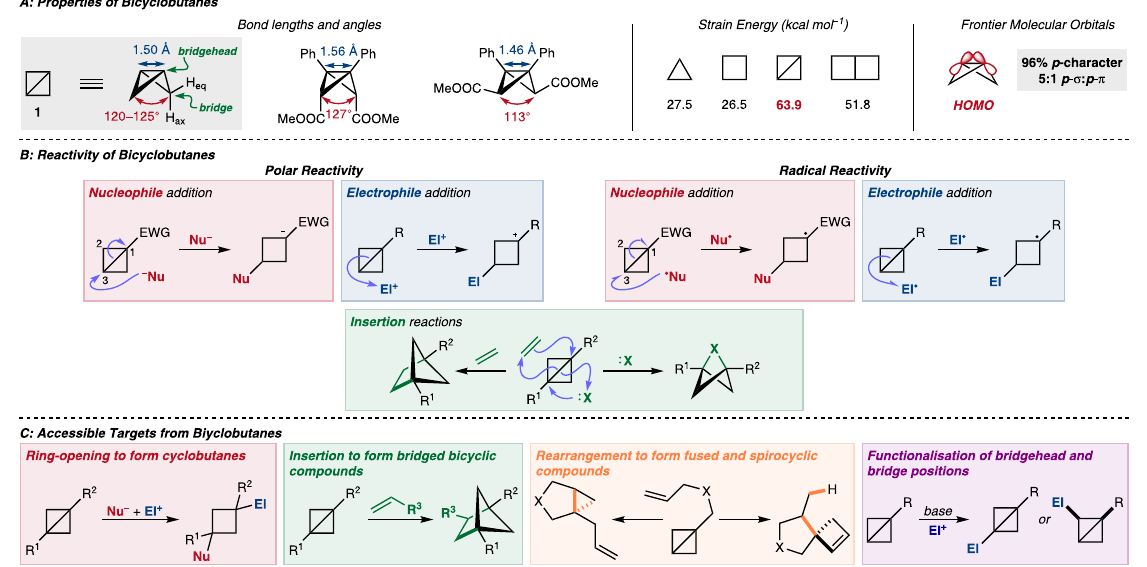
Fig. 1 Introduction to bicyclobutanes. A Properties of bicyclobutanes including bond lengths and angles, the high strain energy of bicyclobutanes in comparison to related structures, and the nature of the highest occupied molecular orbital of bicyclobutanes. B The most important general reactivities of the bicyclobutane scaffold: the addition of polar and radical nucleophiles and electrophiles and the insertion of various one- and two-atom fragments to bridged systems. C The structural classes of compounds that can be prepared from bicyclobutanes. aq axial, eq equatorial, HOMO highest occupied molecular orbital, EWG electron-withdrawing group, Nu nucleophile, El